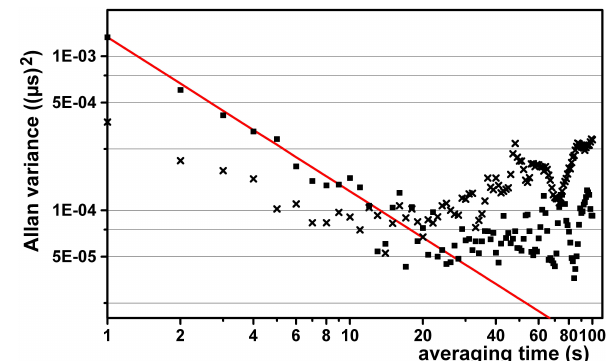
Fig. 8. Ring-down measurement of different NO 2 volume mixing ratios in synthetic air.